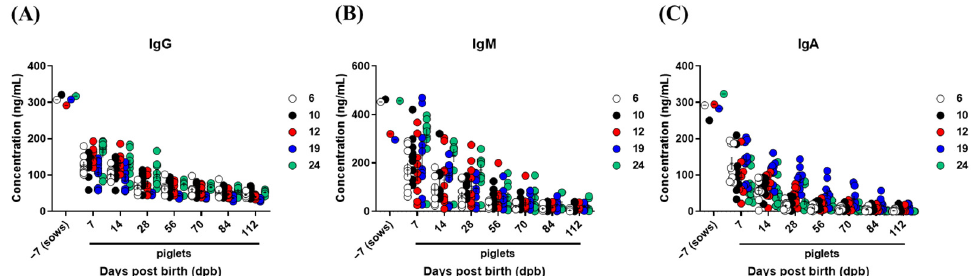
Figure 5. Age-dependent dynamics of IgG, IgM, and IgA in serum from sows and piglets. Five sows and 10 piglets were screened from each sow. For sows, blood was collected 7 days before farrowing, and for piglets born to sows, blood was collected on 7, 14, 28, 42, 56, 84, and 112 days post-birth. The concentrations of IgG, IgM, and IgA were measured using commercially available ELISA kits. Data are present as the mean ± SEM of triplicate measurements (n = 5 for sows or 10 piglets/sow). ( A – C ) represent: ( A ) IgG concentration; ( B ) IgM concentration; ( C ) IgA concentration.